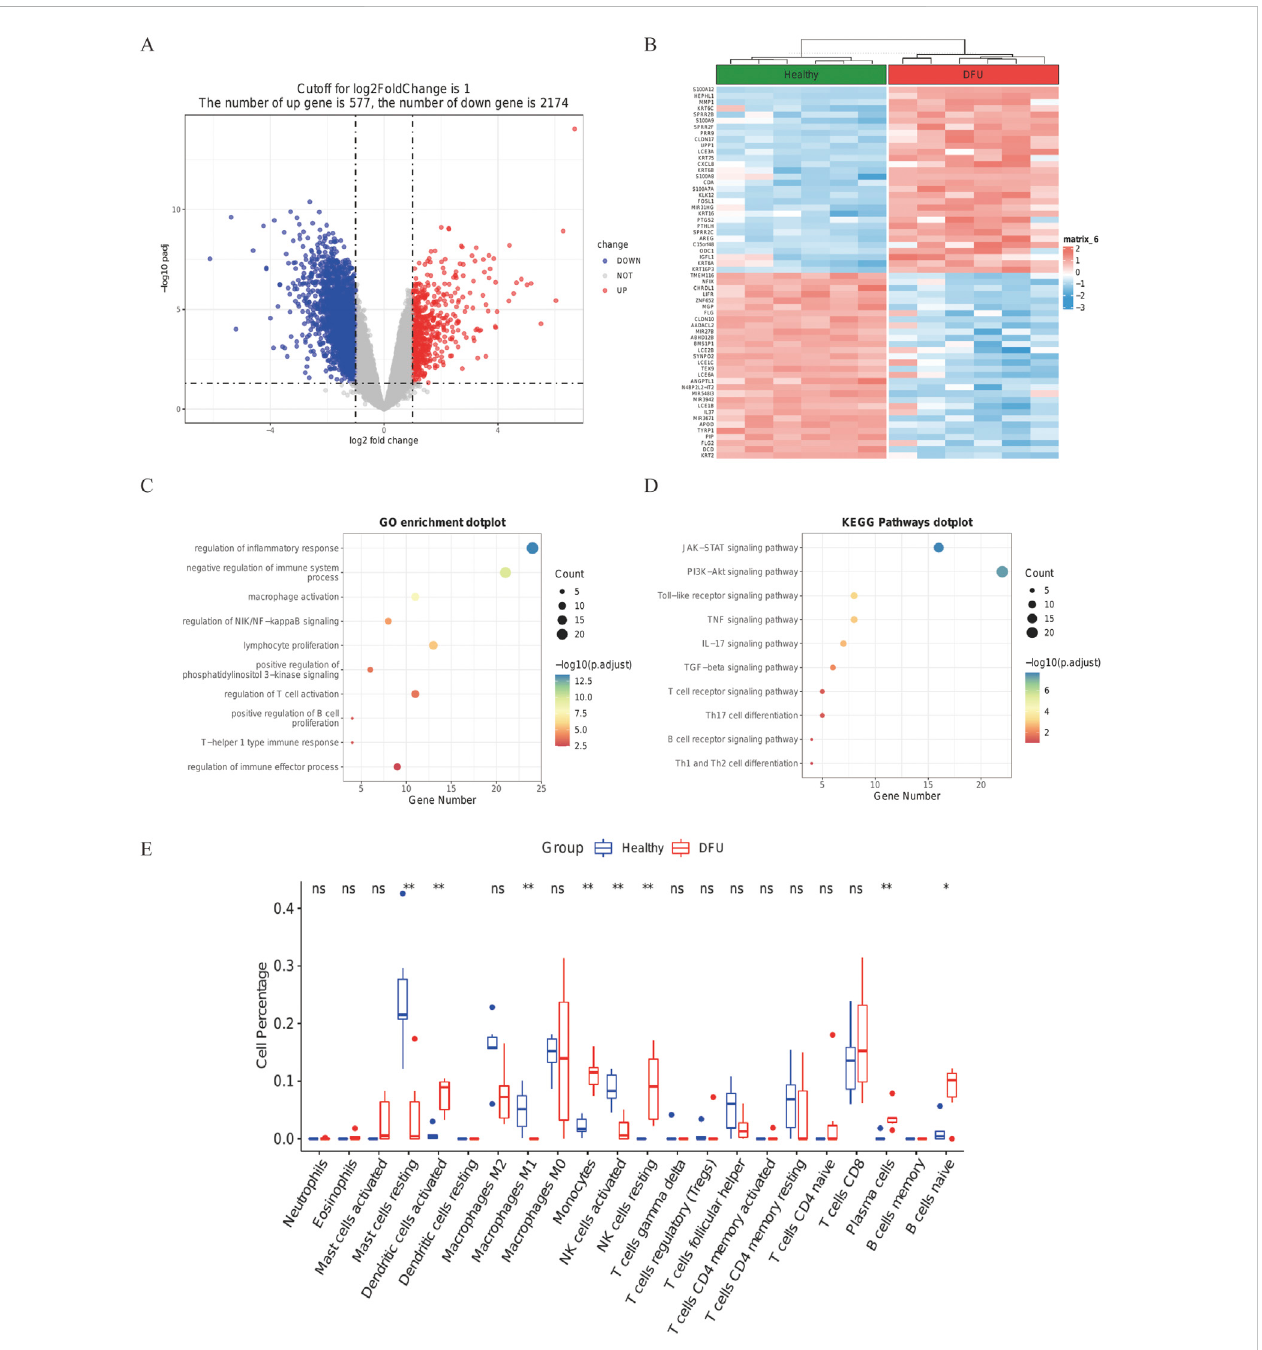
FIGURE 4 DFU DEGs from the GSE80178 database. (A) Volcano plot of DEGs (modi fi ed p -value .05; |logFC| > 1). Red indicates up-regulated genes, and blue indicates down-regulated genes. (B) Heatmap showing GSE80178 ’ s top 30 up-regulated DEGs and top 30 down-regulated DEGs. (C) GO of DEGs in GSE80178. (D) KEGG of DEGs in GSE80178. (E) Analysis of immune in fi ltration based on CIBERSORT ( p <